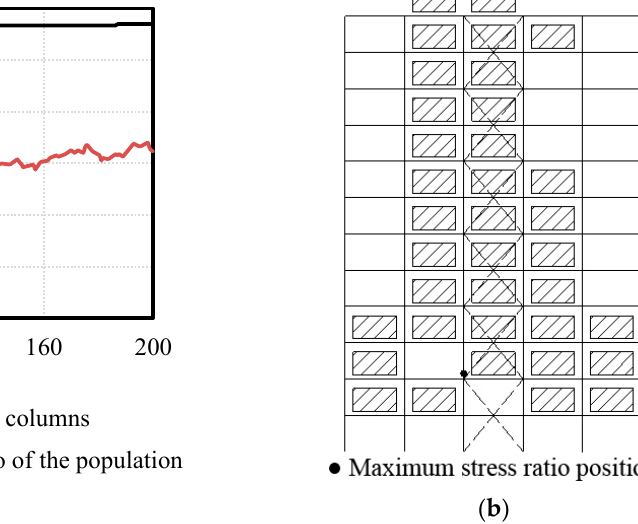
Figure 8. The most unfavorable distribution of load under 60% full load. ( a ) Tracking chart of optimization performance of GA. ( b ) The most unfavorable distribution of load (H = 5.67, P = − 0.08).